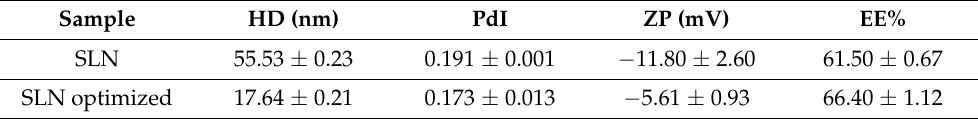
Table 5. HD, PdI, ZP, and EE% values before and after BB